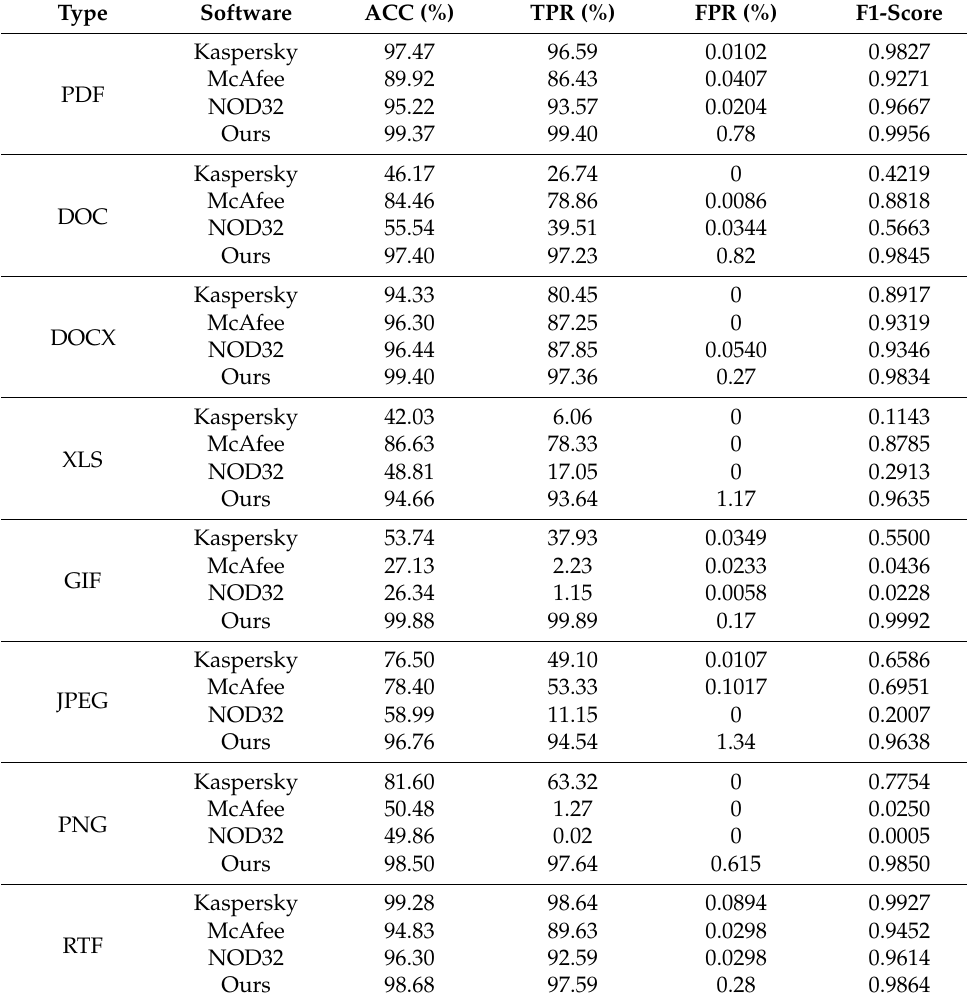
Table 9. The experimental results of the detection of different types of malicious documents by different antivirus